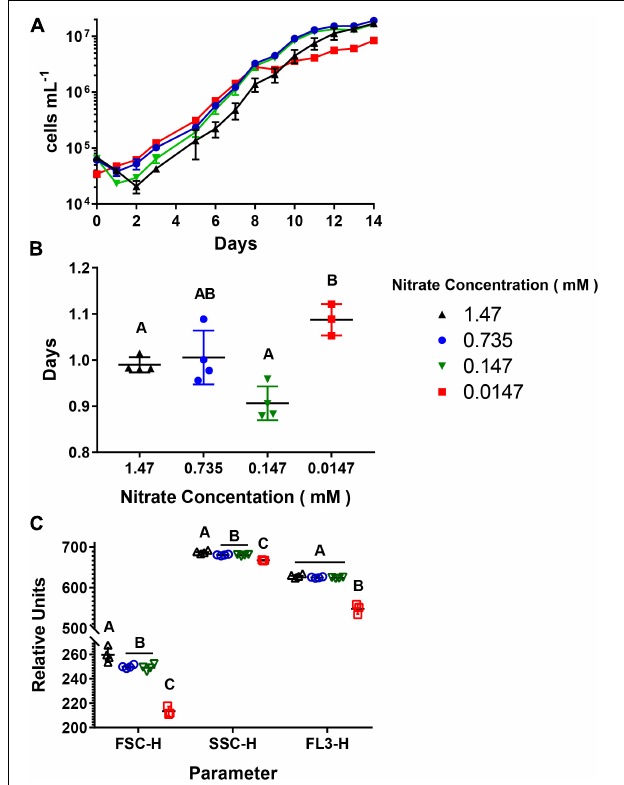
FIGURE 1 | Growth characteristics of Aureococcus anophagefferens acclimated to decreasing NO − 3 concentrations. (A) A. anophagefferens concentration over time. (B) Doubling times of A. anophagefferens . (C) Flow cytometry averages of two consecutive days of A. anophagefferens populations during logarithmic growth. FSC-H = forward scatter, SSC-H = side scatter, and FL3-H = chlorophyll a fluorescence. The different nitrate conditions are represented by the following colors and shapes: 1.47 mM – black upward triangles, 0.735 mM – blue circles, 0.147 mM – green downward triangles, and 0.0147 mM – red squares. Letters indicate that the two values being compared are not significant ( p > 0.05). Tables with significance values are Supplementary Tables 1 and 2 for data for Figures B and C , respectively. Points are for n = 4 biological replicates ±